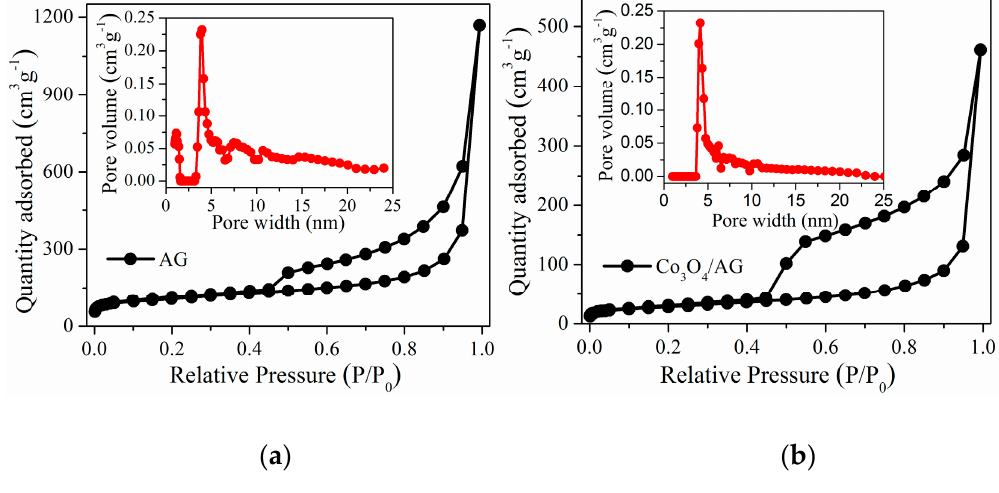
Figure 4. Nitrogen adsorption and desorption isotherms (inset: pore size distribution) of samples: ( a ) AG and ( b ) the Co 3 O 4 /AG nanocomposite.